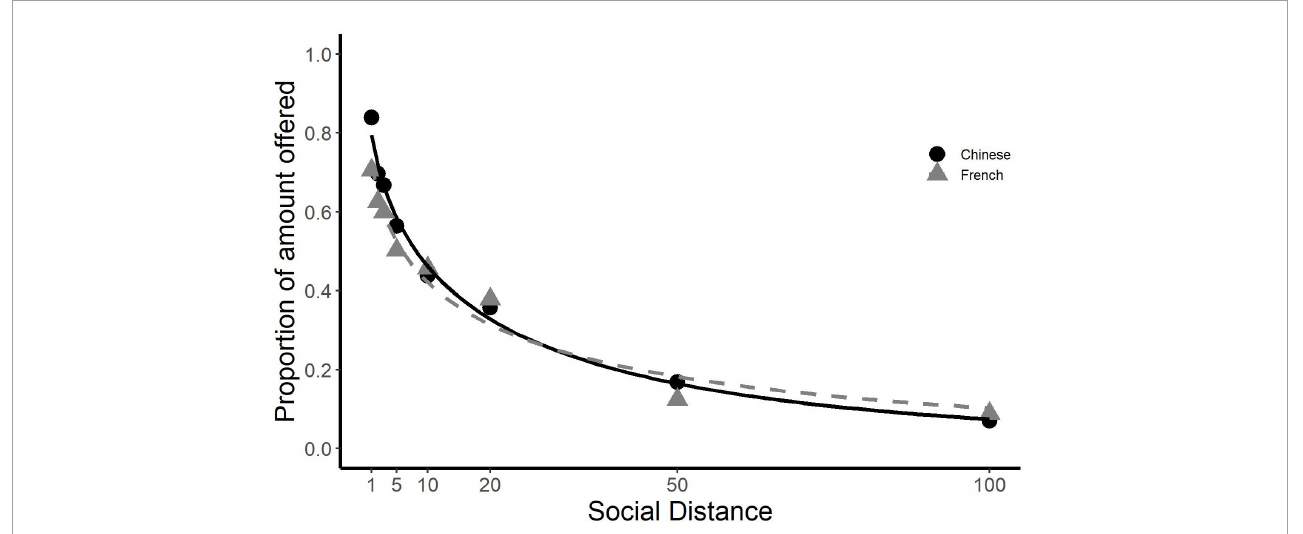
FIGURE3 Social discounting behavior of Chinese and French participants in the Constant Sensitivity model. The graph shows the proportions of endowments offered by the participants to recipients at each social distance, as estimated by the Constant Sensitivity model, which was globally the best model to account for social discounting for all participants and for the Chinese participants in particular. Although it was not the best model of the French students’ discounting behavior, it fit them similarly well as the